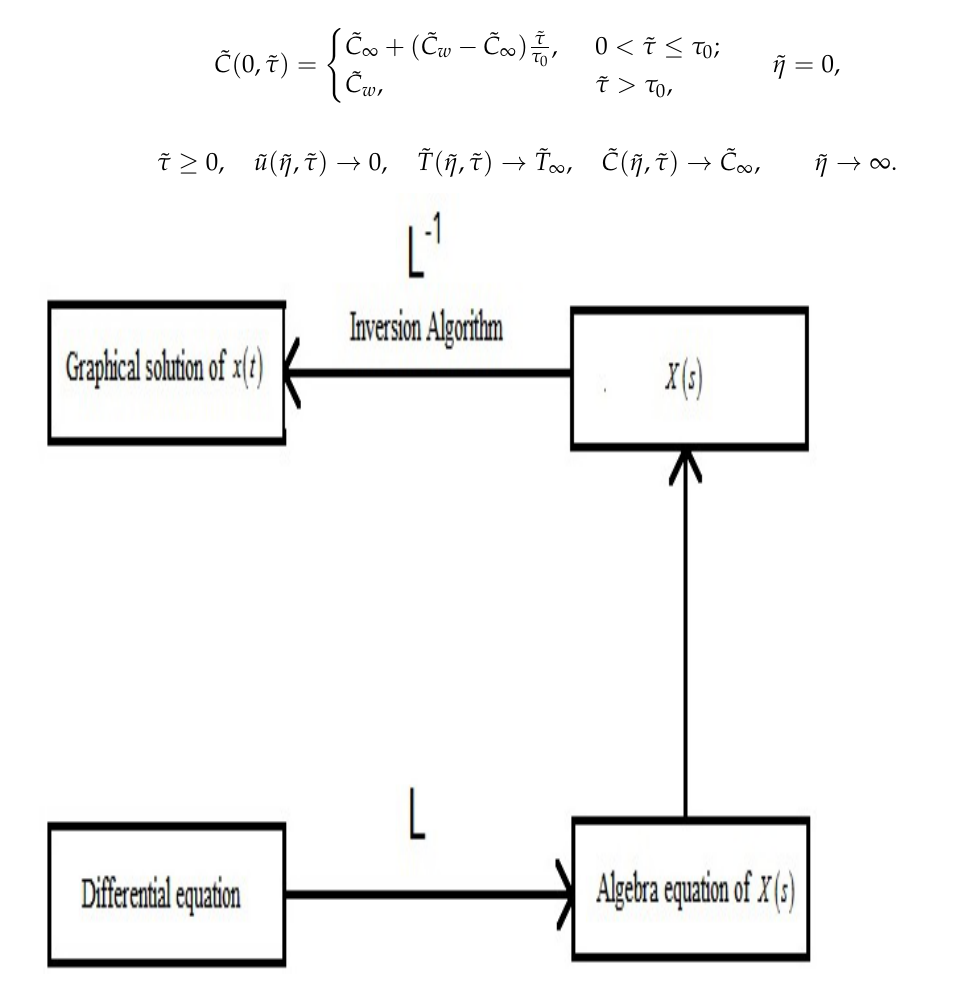
Figure 2. Flow chart of the